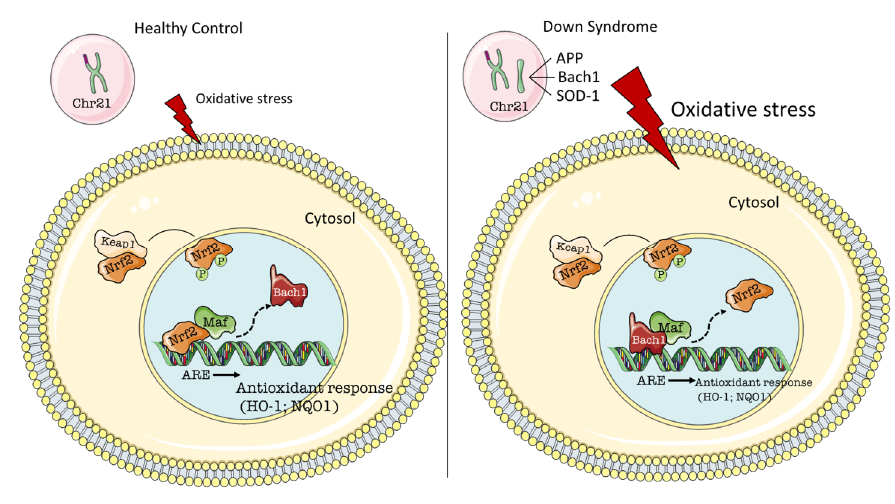
Figure 1. BACH1 / Nrf2 signaling regulates antioxidant response . Under normal conditions ( left ), Keap1 / Nrf2 retains Nrf2 in the cytoplasm. Exposure of cells to oxidative insult leads to the release of Nrf2 from Keap1 / Nrf2. Nrf2 then translocates to the nucleus and binds to MAREs as a heterodimer with small Mafs, thereby activating oxidative stress-response genes (e.g., HO-1 and NQO1), while Bach1 is displaced from MAREs and exported out of the nucleus. In trisomic cells (DS) ( right ), triplication of BACH1 competes with Nrf2 thus resulting in reduced binding of Nrf2 to MAREs. This event may explain the increased oxidative stress levels of DS individuals, that is likely the result of compromised induction of antioxidant response.